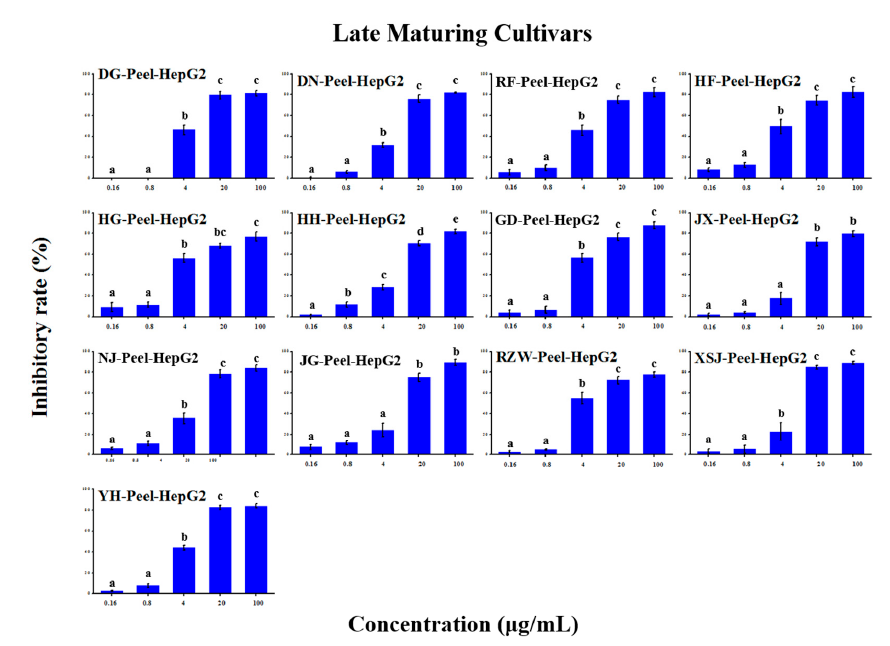
Figure 5. HepG2 growth inhibition e ff ect of peel extracts from late maturing cultivars.The names of apple cultivars were showed as abbreviations: JX for ‘Jingxiang’, XSJ for ‘Xinshijie’, DG for ‘Danguang’, DN for ‘Dounan’, HH for ‘Huahong’, YH for ‘Yuehong’, NJ for ‘New Jonagold’, RZW for ‘Rizhiwan’, HF for ‘Hanfu’, HG for ‘Huaguan’, RF for ‘Red Fuji’, JG for ‘Jonagold’, GD for ‘Gold Delicious’. Di ff erent lowercase letters above the bars indicated significant di ff erences at the 0.05 probability level by Tukey test.